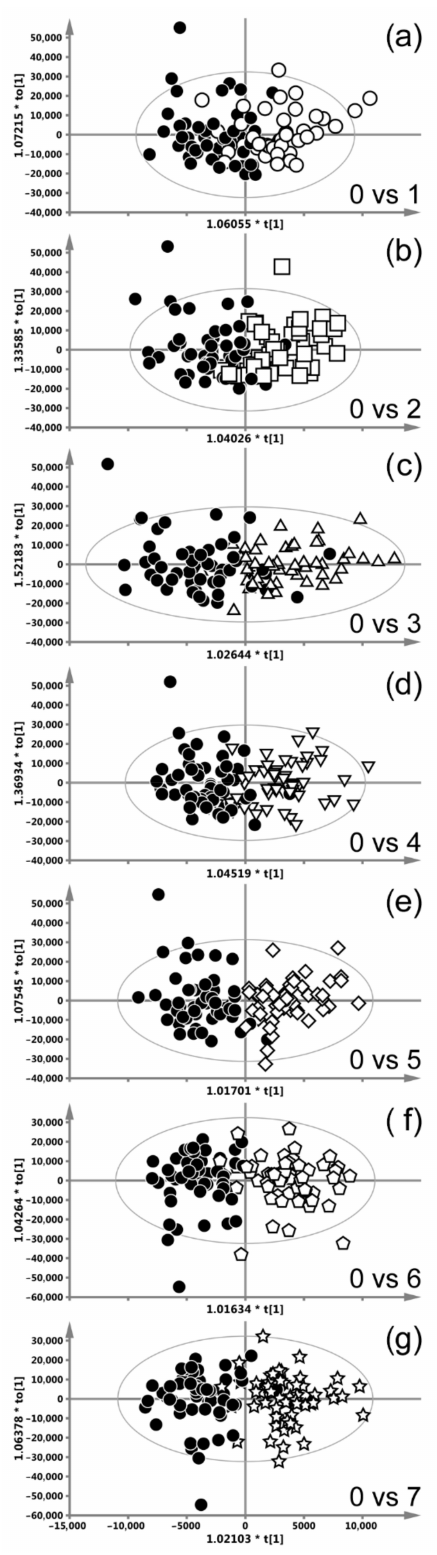
Figure 2. OPLS-DA scores plots differentiating week-0 from the consecutive weeks of radio- chemotherapy (CHRT), the x-scale (predictive direction t [1]) is the same for all plots. Week-0 vs. week-1 ( a ), week-2 ( b ), week-3 ( c ), week-4 ( d ), week-5 ( e ), week-6 ( f ) and week-7 ( g